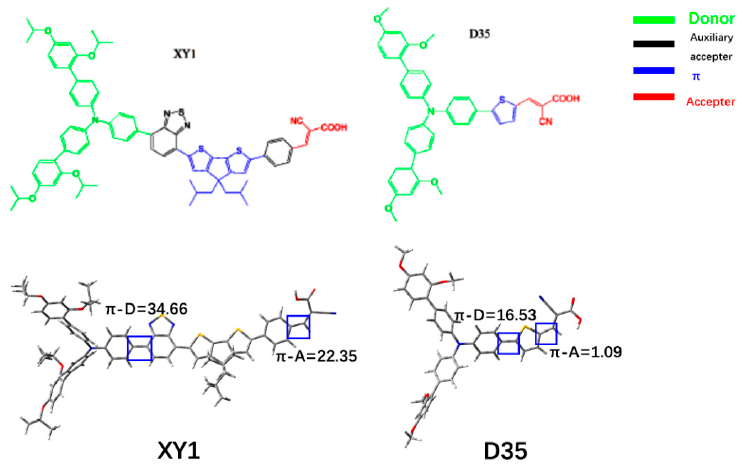
Figure 1. Chemical and optimized structures for D35 and XY1, respectively.